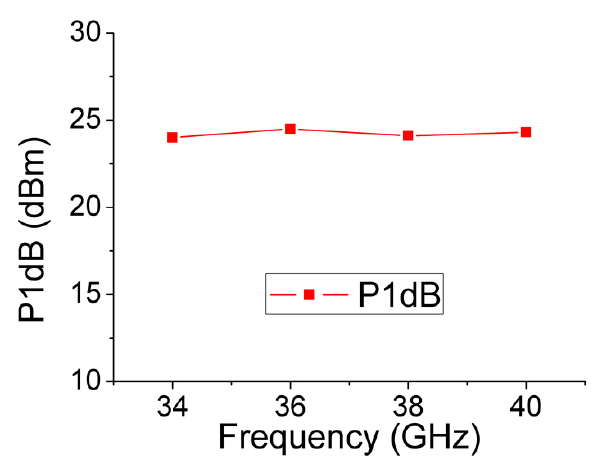
Figure 14. Measured P 1dB across the frequency band of interest of the SPDT switch.